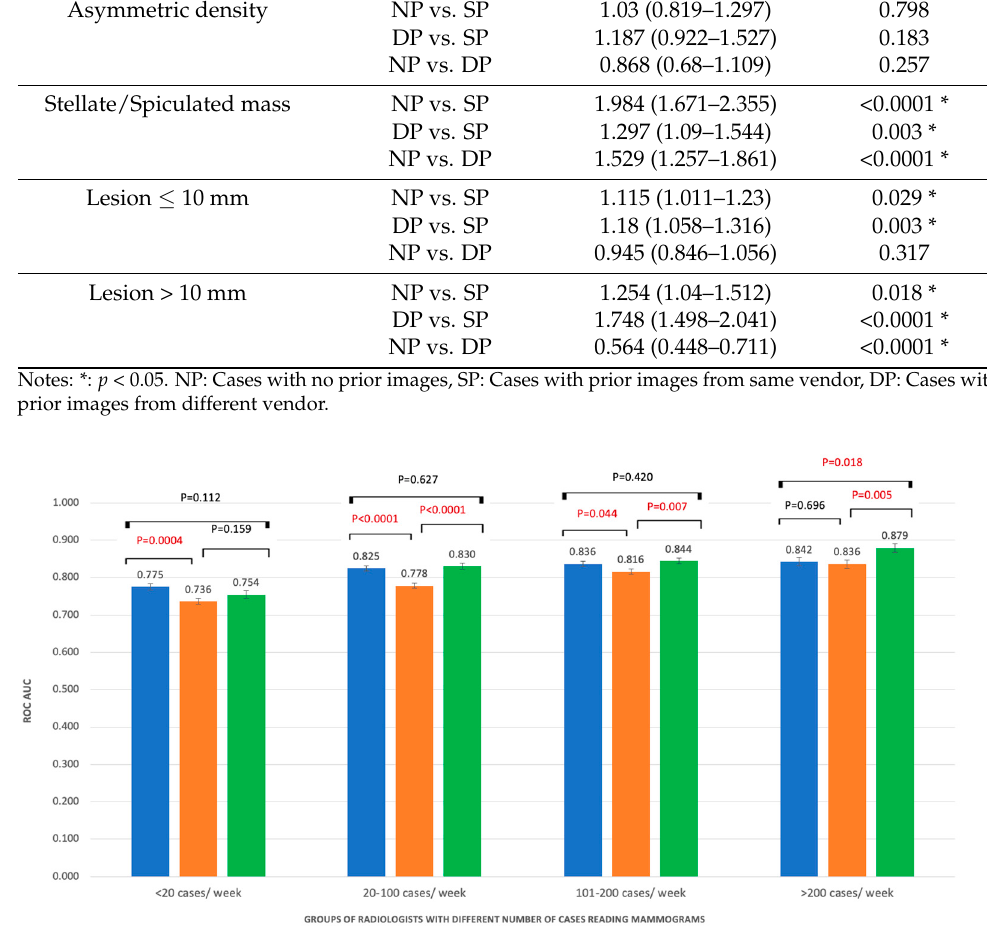
Figure 3. ROC AUC performances of radiologists with different experience in number of years read- ing mammograms. 4. Discussion In general, results from this study showed that radiologists obtained higher true pos- itive rates and AUC values when reading cases without prior images, or with prior images obtained from different vendors, than cases with prior mammograms undertaken from the same vendor. The study also provided an estimation of the odds ratio for true positive, true negative and true cancer lesion localization among three case groups in different lev- els of breast density and lesion characteristics.